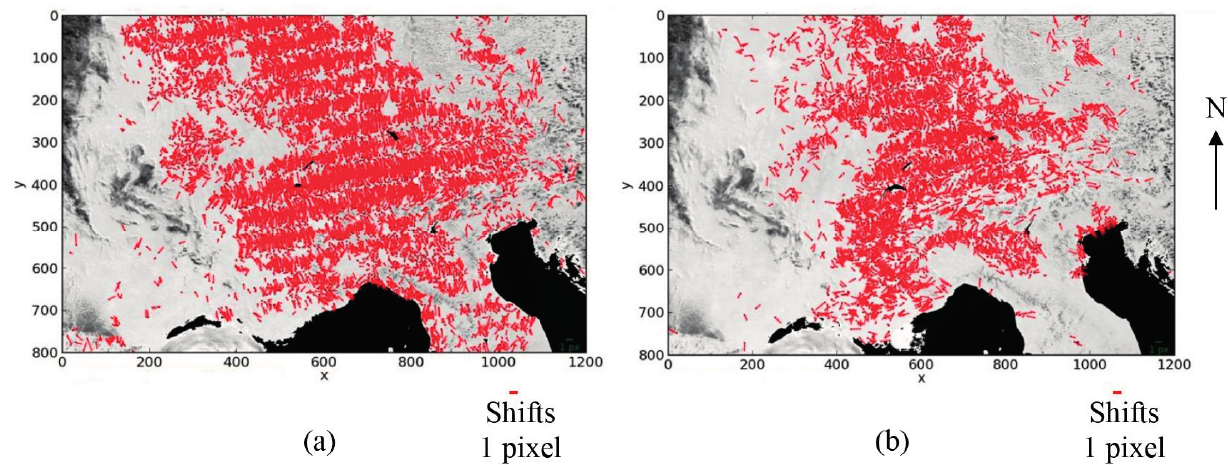
Figure 12. Image space shifts obtained from matching of NOAA-18-NOAA-19 ( a ) and NOAA-17-NOAA-19 ( b ) images acquired on 6 August 2009. The axes denote the image